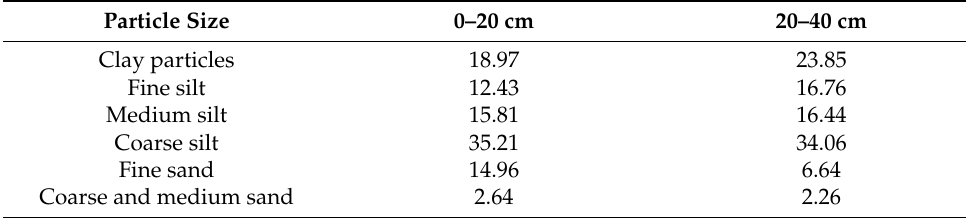
Table 2. Composition of soil particles in the study area (unit: